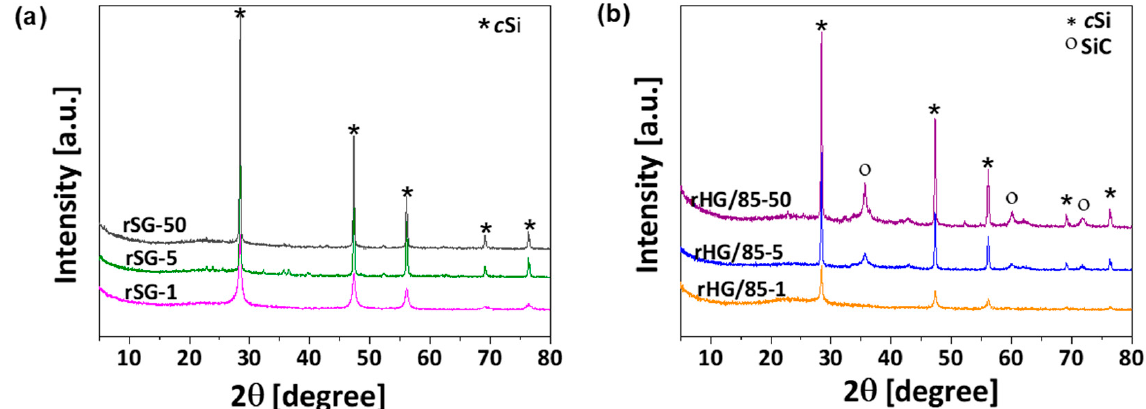
Figure 5. Crystalline species developed on reduced materials obtained from ( a ) silica gels and ( b ) C-Si hybrid gels precursors using different heating rates.